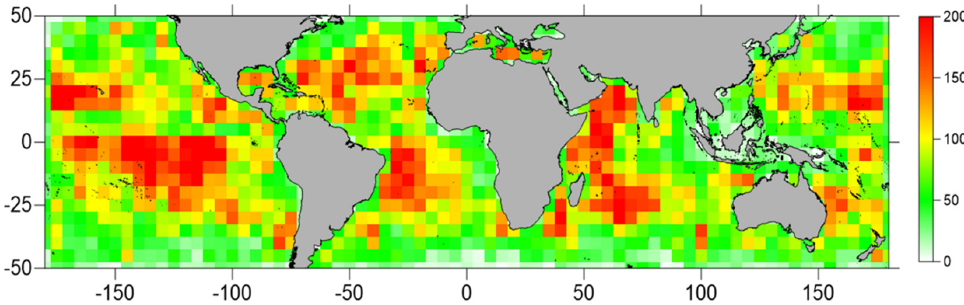
Figure 3. Number of collocations between Sentinel-3A SRAL/MWR measurements of the test dataset with SI-MWR, represented in a grid with a 5° by 5° spatial resolution.